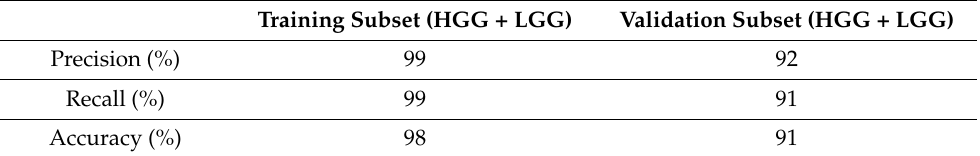
Table 4. Tumor binary classification: precision, recall and accuracy of the training BraTS 2017 dataset.